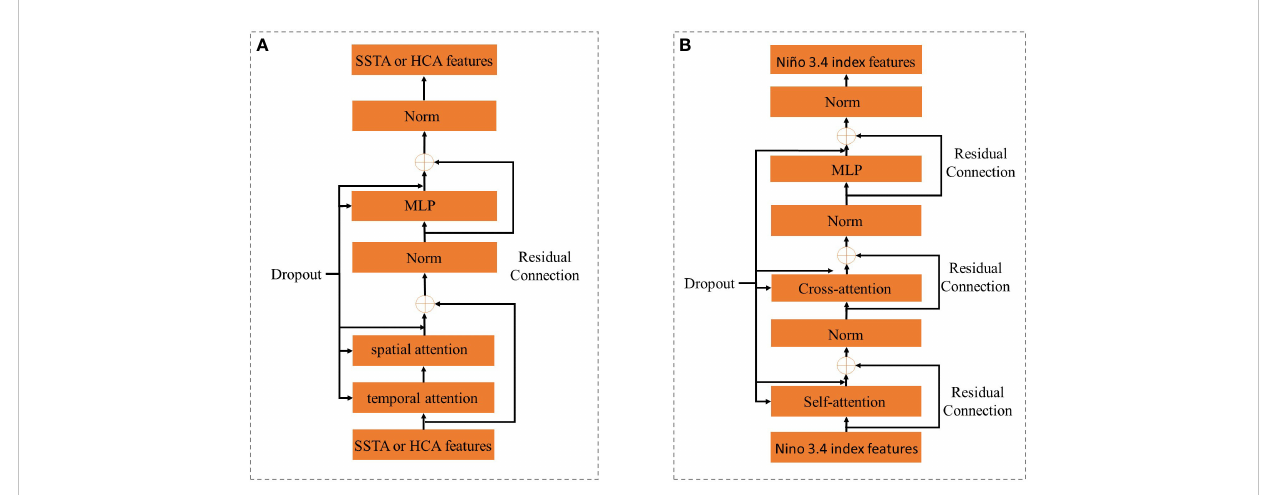
FIGURE 2 The Encoder and Decoder Blocks. The input to the Encoder Block is the SSTA (HCA) feature output by the upper-level block. The input to the Decoder Block is the Niño3.4 index feature output by the upper-level